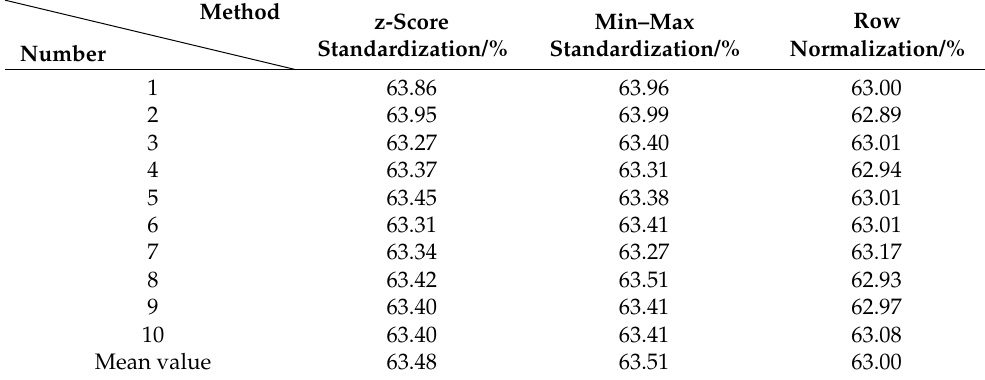
Table 6. Prediction accuracies achieved by the RF classifier on the three